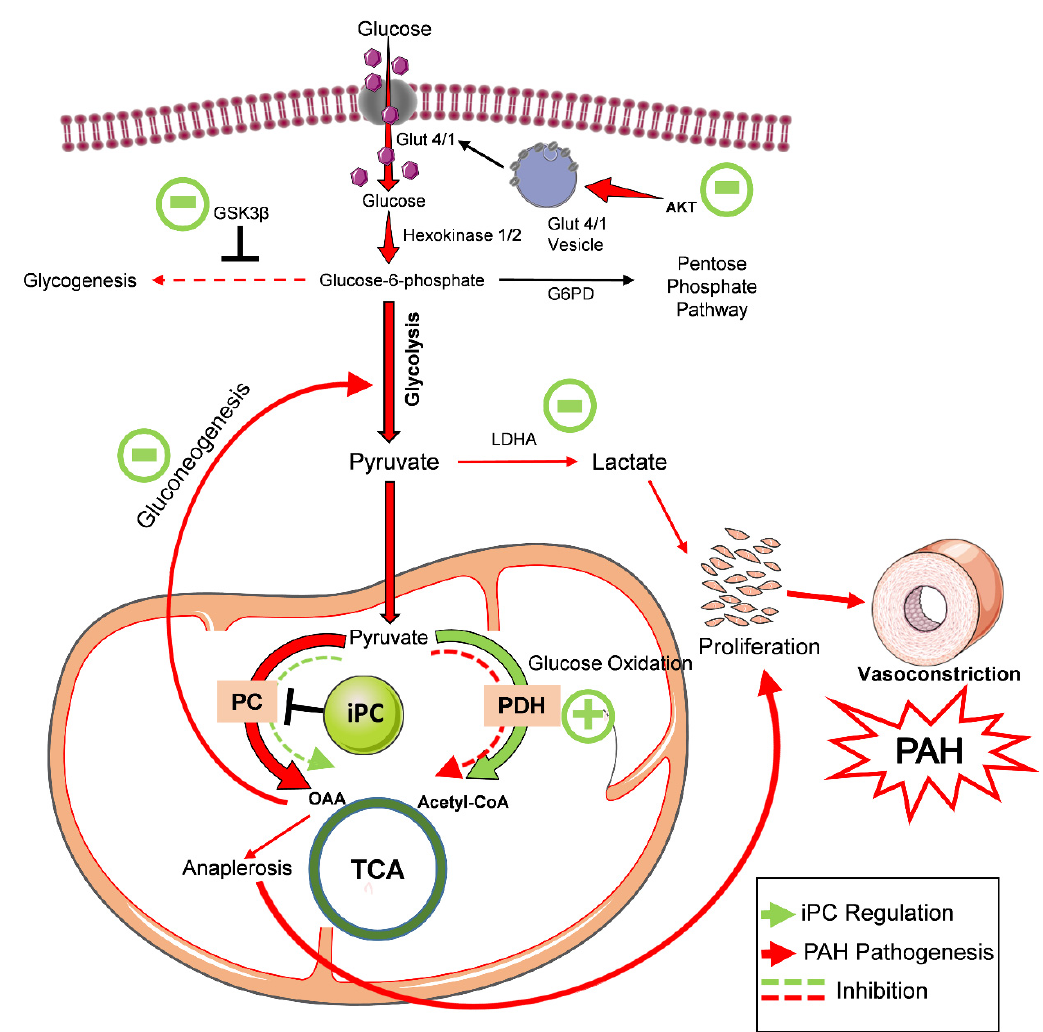
Figure 7. PC inhibitor attenuated glycolytic shift and metabolic reprogramming in pulmonary hypertension. In the sugen / hypoxic PAH model, phosphorylation of Akt upregulated cellular glucose uptake and glycolysis. This results in decreased oxidative phosphorylation, increased anaplerosis, and a reduction in glycogenesis. Increased anaplerosis and lactic acidosis feed-forward increased cellular proliferation and vascular remodeling in PAH. PC inhibitor treatment balanced cellular glucose influx, glycogen synthesis, and raised pentose phosphate pathway. As a result, glycolytic shift and improved oxidative phosphorylation returned back to control by inhibiting the key anaplerotic enzyme, PC, in PAH. Thus, proliferative pathological changes in PAH were found to be preserved